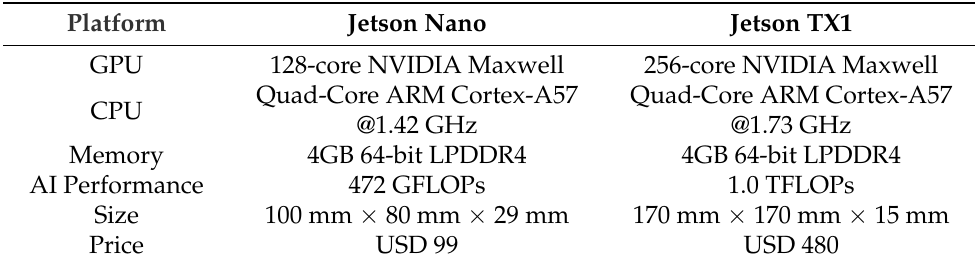
Table 7. Specification of Jetson Nano and Jetson TX1.